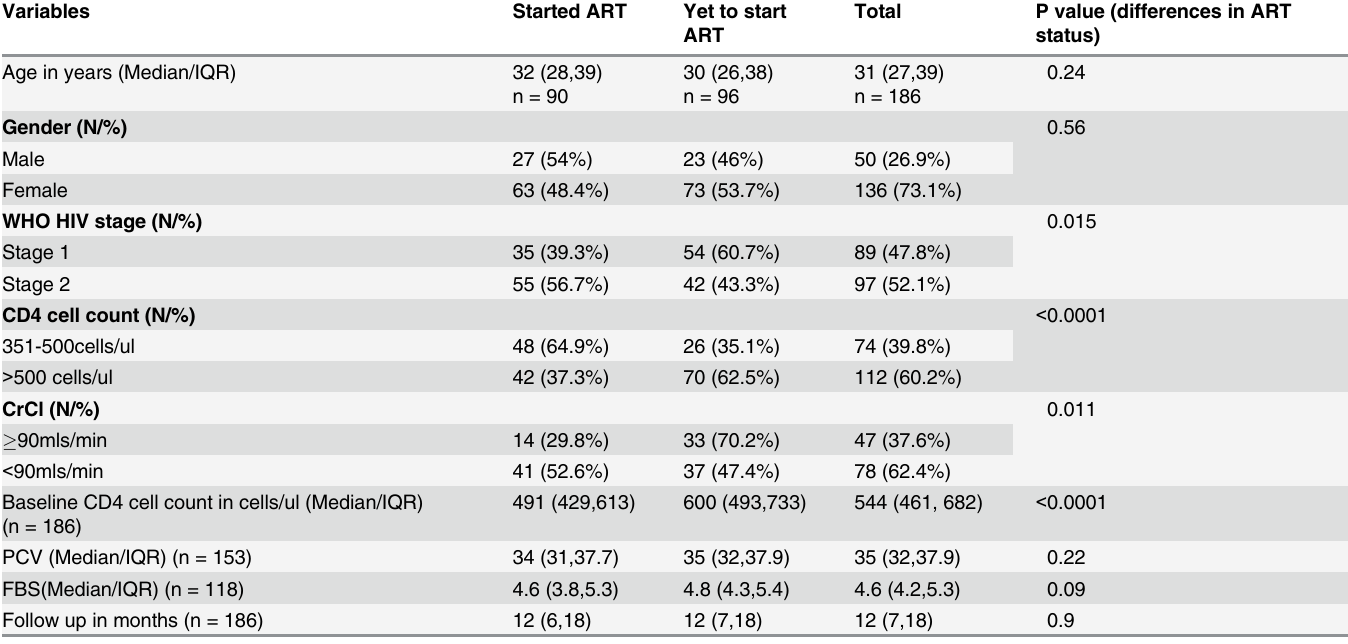
Table footnote: ART-antiretroviral therapy, IQR-inter-quartile range, CrCl-creatinine clearance, n-number, PCV-packed cell volume, FBS-fasting blood